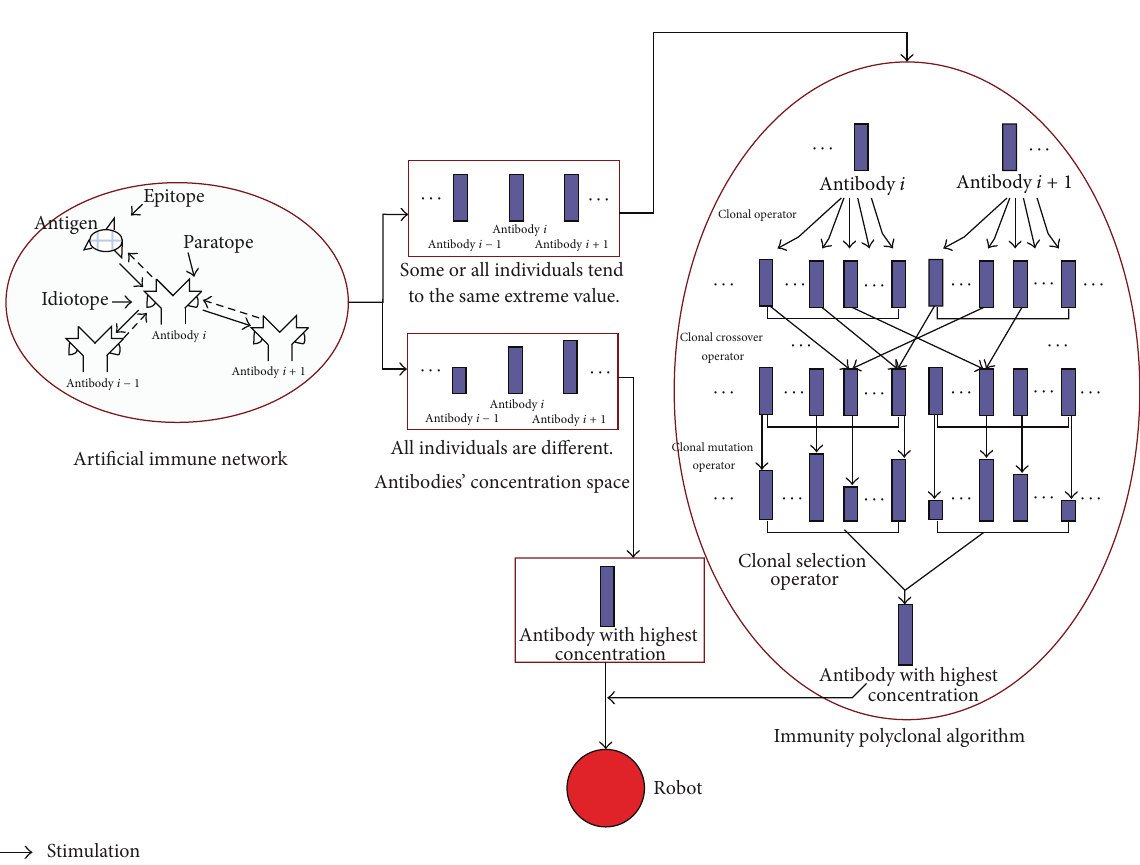
Figure 1: The graphic representation of the proposed path planning system. Antigen represents the local environment surrounding the robot. Antigen’sepitoperepresentsadatasetdetectedbysensorsincludingtheazimuthofthegoal,thedistancebetweenobstaclesandsensor,andthe azimuth of sensor. Antibody represents robot’s steering direction. The interaction between antibodies is achieved by idiotope and paratope. Only the antibody with highest concentration will be selected to act on